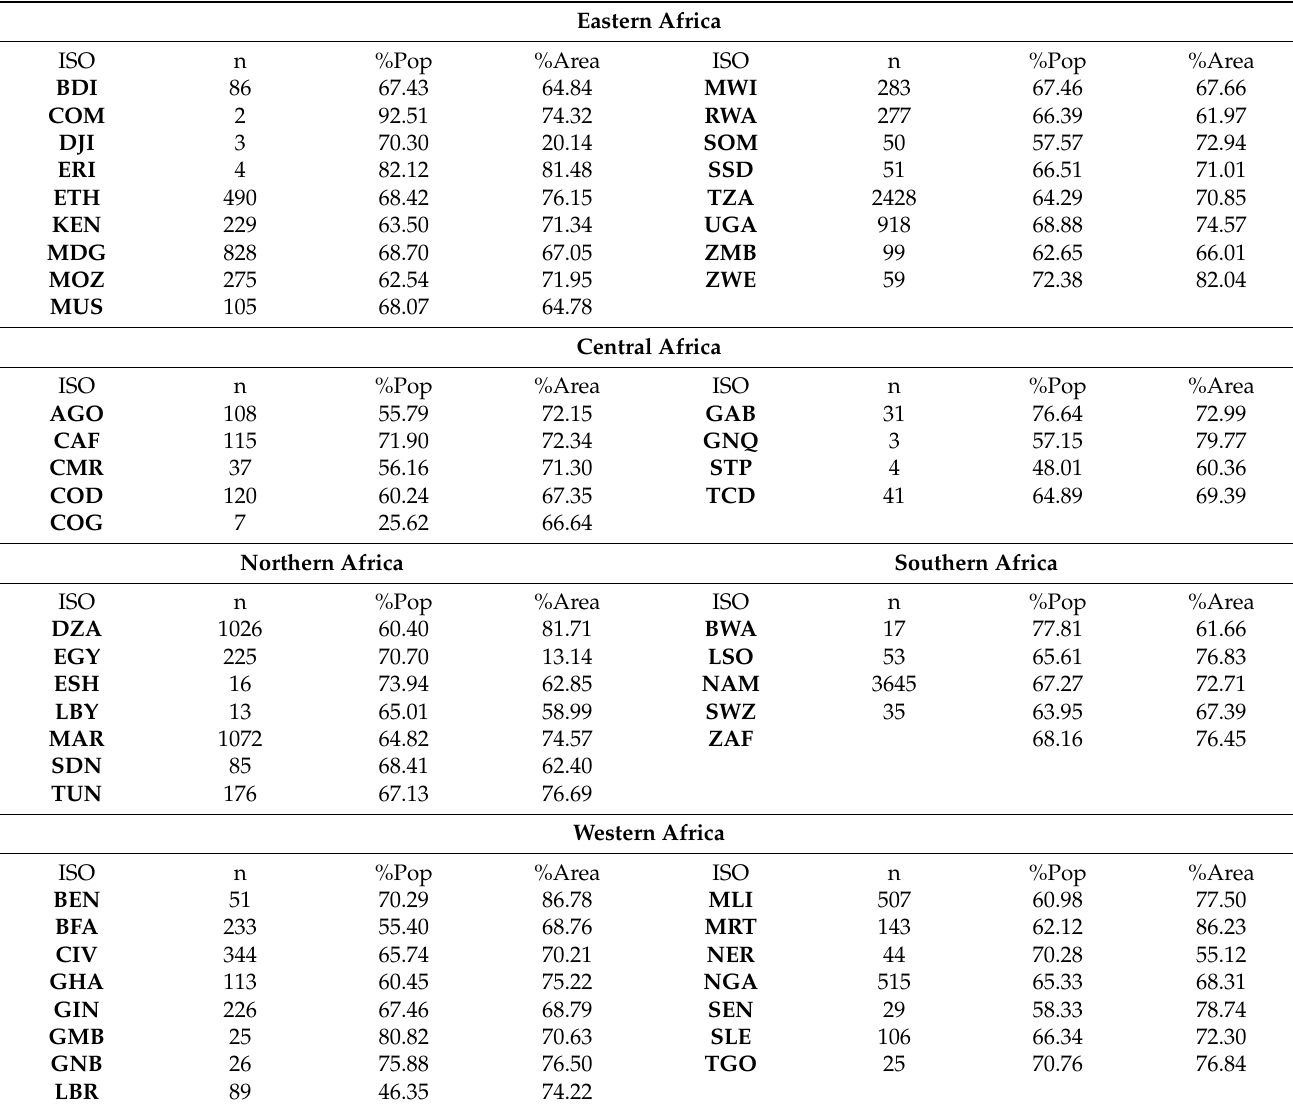
Table 2. Summary of the sampled L1-units for each country grouped by